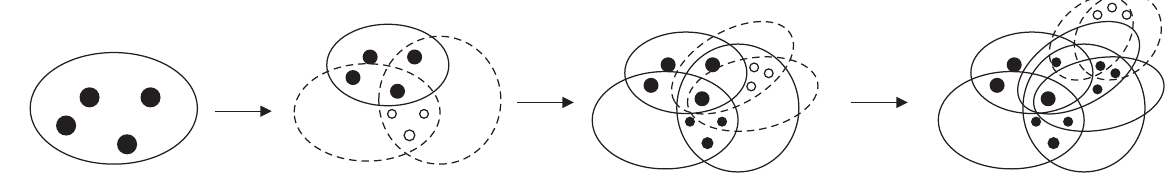
Figure 5: The evolution process of a